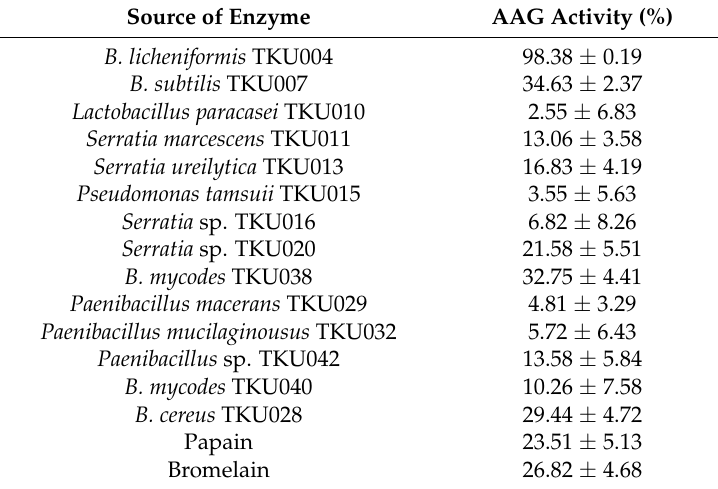
Table 3. Comparison of the AAG activity produced by various